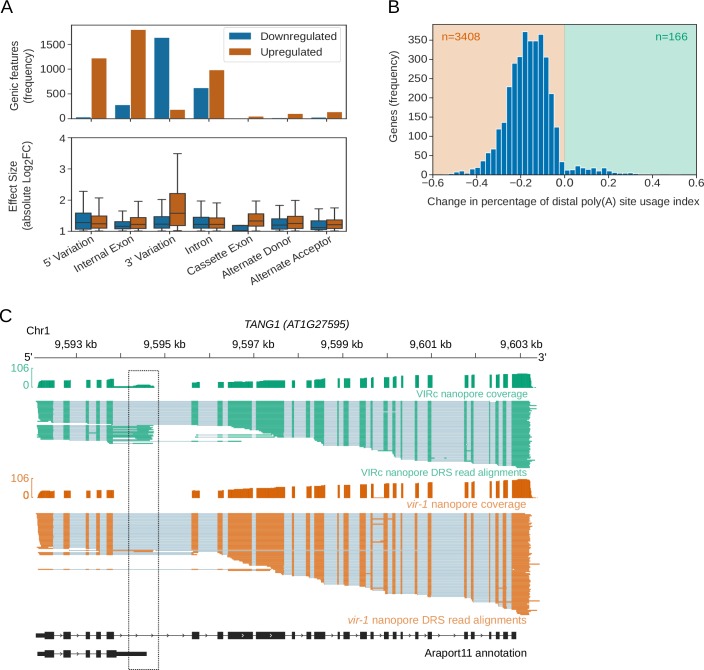
Changes in RNA 3′ end formation in the vir-1 mutant.(A) Splicing is moderately disrupted in the vir-1 mutant. Results of differential exon usage analysis with DEXseq are shown for contiguous regions (‘exon chunks’), which occur in the same sets of transcripts in the Araport11 reference. Regions were classified as a 5′ or 3′ variation if they were bounded by the TSS of one or more transcripts. Orange, features with increased usage; blue, features with reduced usage. Boxplots show the distribution in absolute log2 fold change for each feature set. (B) DaPars analysis of Illumina RNAseq data indicates global 3’UTR shortening in the vir-1 mutant. Histogram showing the change in the percentage of distal poly(A) site usage in vir-1 compared to VIRc. Only genes which are significantly differentially polyadenylated (FDR < 0.05) are shown. There is a clear directional effect towards proximal poly(A) site use. (C) vir-1 mutant exhibits increased readthrough of an intronic proximal poly(A) site in intron 5 of the Symplekin domain encoding gene TANG1 (AT1G27595). Green track, nanopore DRS coverage from VIRc; green, nanopore DRS isoforms from VIRc; orange track, nanopore DRS reads from the vir-1 mutant; orange, nanopore DRS isoforms from vir-1; black, Araport11 annotation; dashed black box highlights the site of proximal polyadenylation.Figure 7—figure supplement 1—source data 1.Differential exon usage for vir-1 vs VIRc, derived from Illumina RNAseq - Figure 7—figure supplement 1A.Figure 7—figure supplement 1—source data 2.Differential poly(A) site choice results for vir-1 vs VIRc, derived from Illumina RNAseq data – Figure 7—figure supplement 1B.